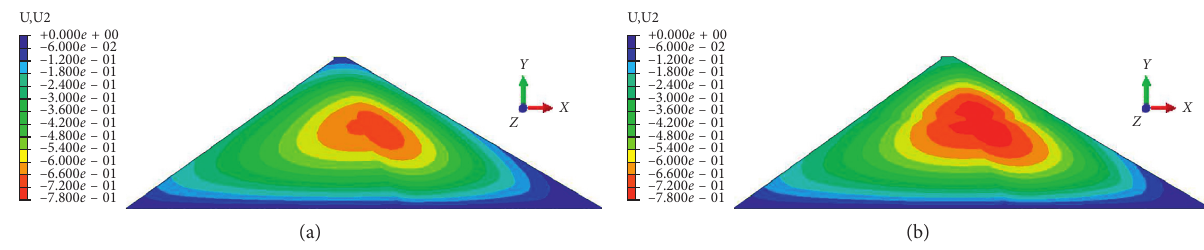
Figure 11: Settlement nephogram at section D0+163.8 after 3 years of water storage. (a) Without Creep. (b) Creep. Table 8: The displacement monitoring table of typical high face rockfill dams.